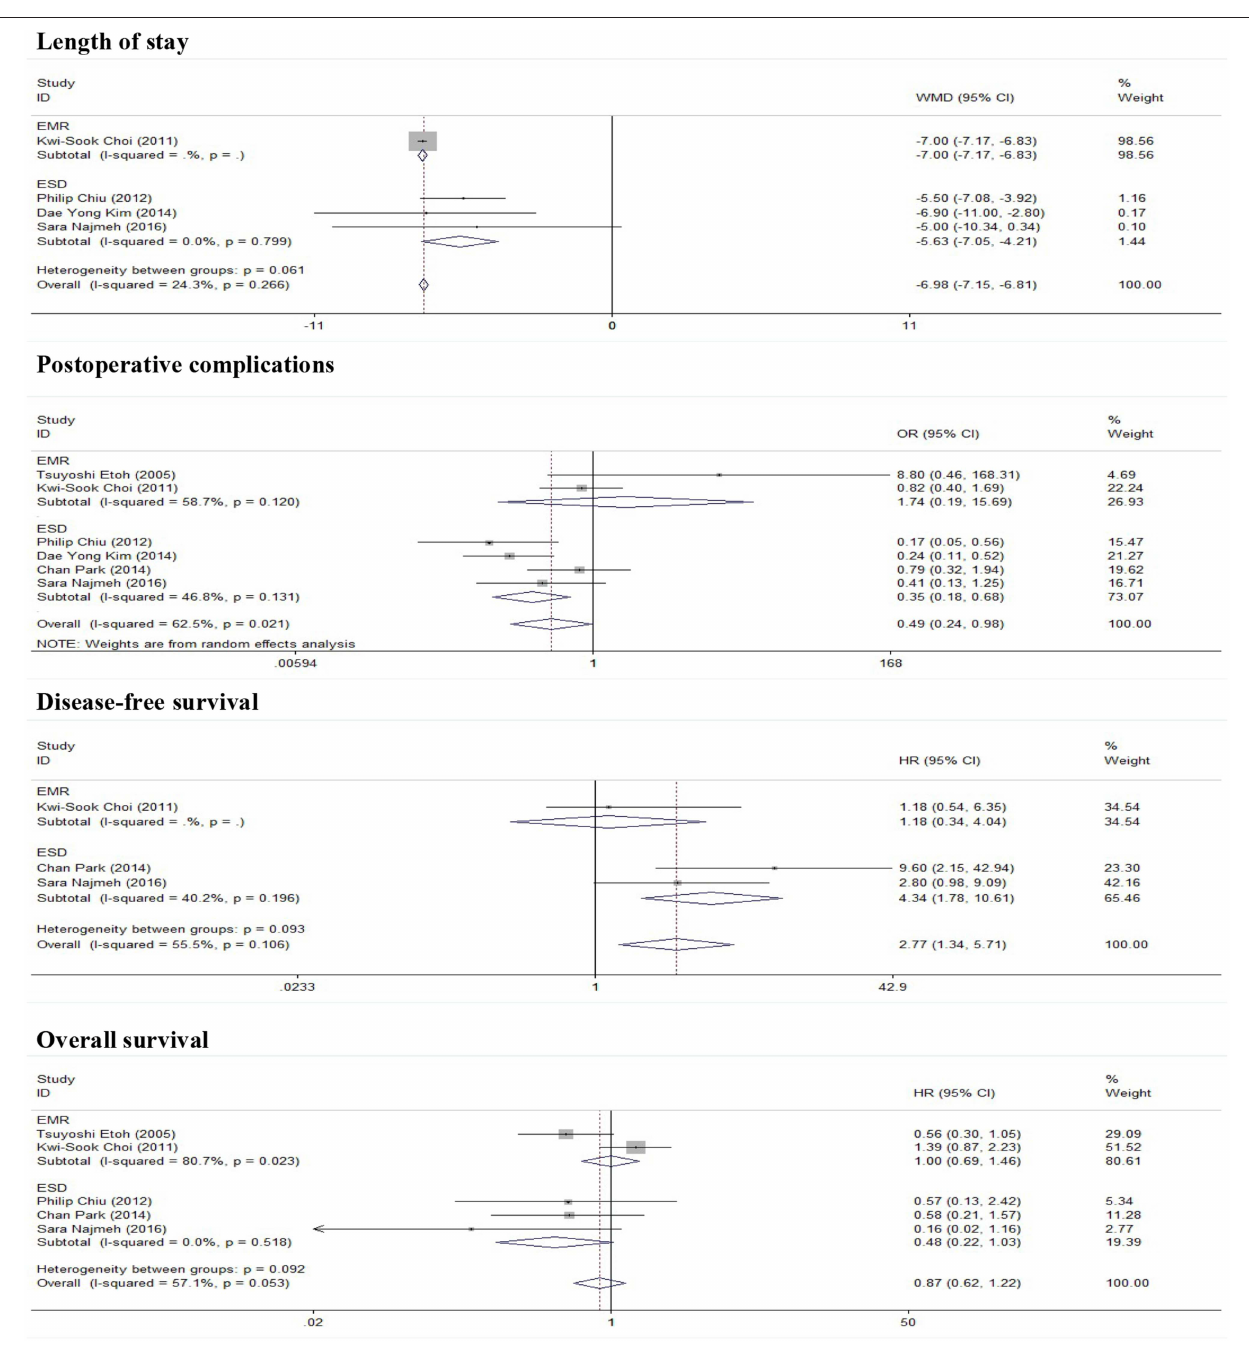
FIGURE 4 | Subgroup meta-analysis of ER